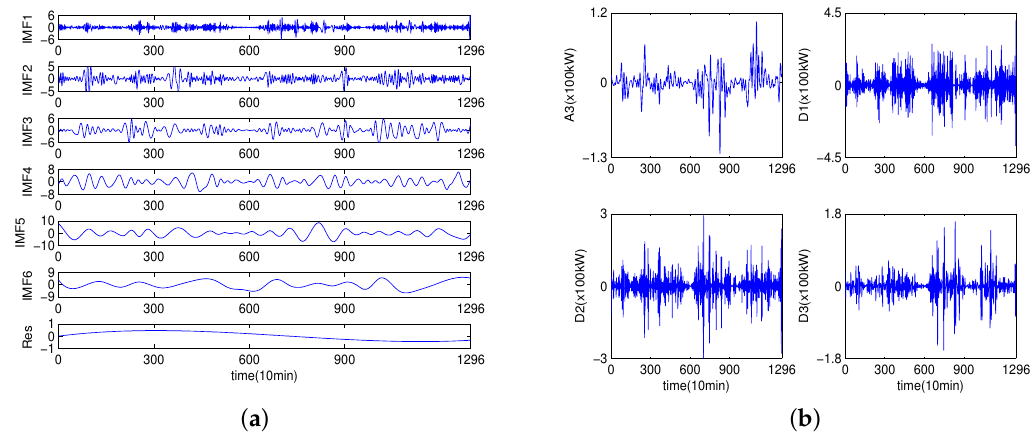
Figure 7. Empirical wind power data decomposed by two-stage decomposition (TSD) method. ( a ) Decomposition of wind power by Ensemble Empirical Mode Decomposition (EEMD) ( × 100kW). ( b ) Decomposition of IMF1 by wavelet transform (WT).